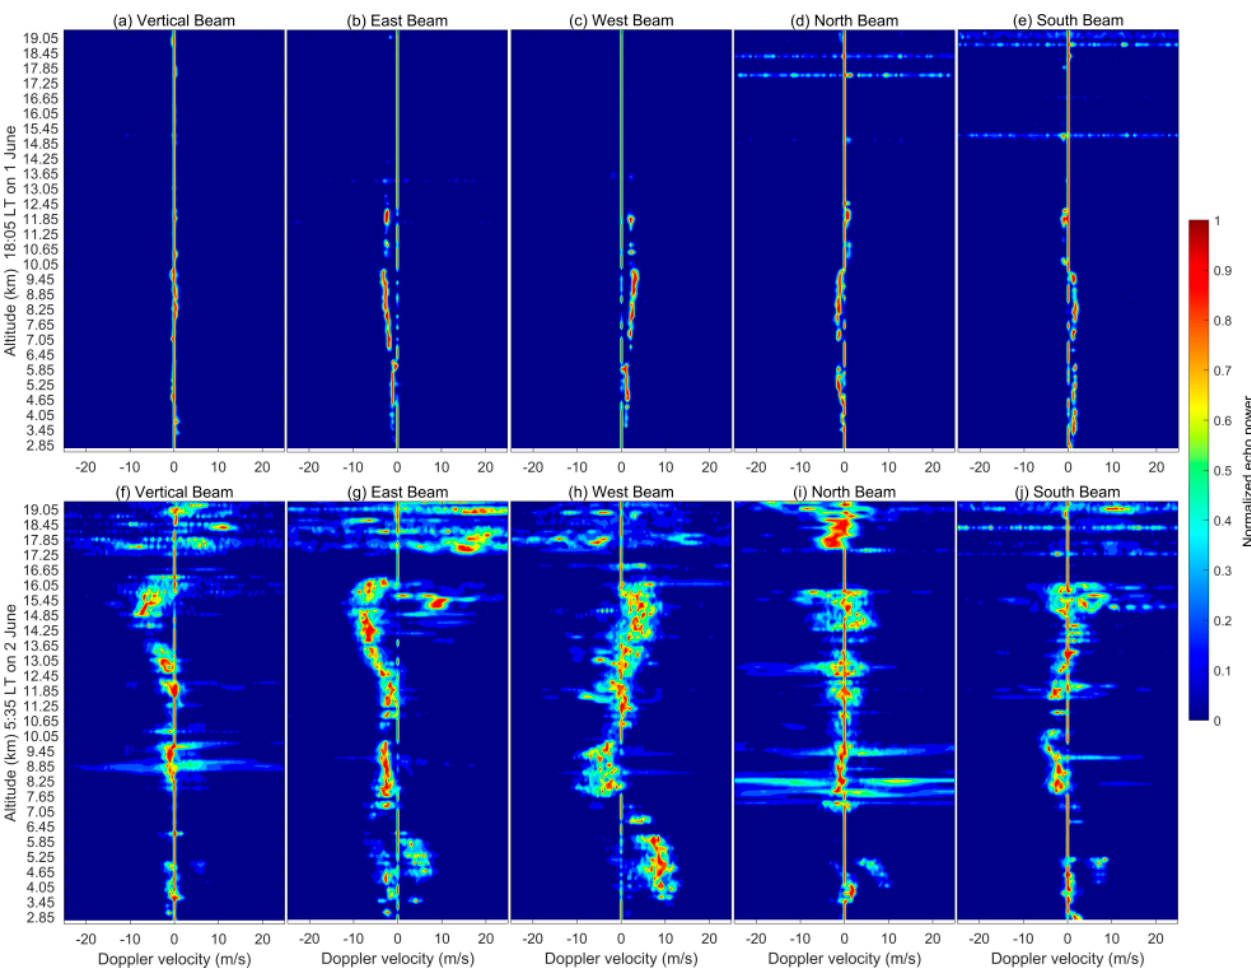
Figure 8. Echo Doppler spectra between 2.85 and 19.05 km heights recorded by the five beams of the Wuhan MST radar at 18:05 LT on 1 June 2015 ( top row ) and 5:35 LT on 2 June 2015 ( bottom row ), respectively. The echoes recorded by the vertical, east, west, north, and south beams are listed from left to right columns.